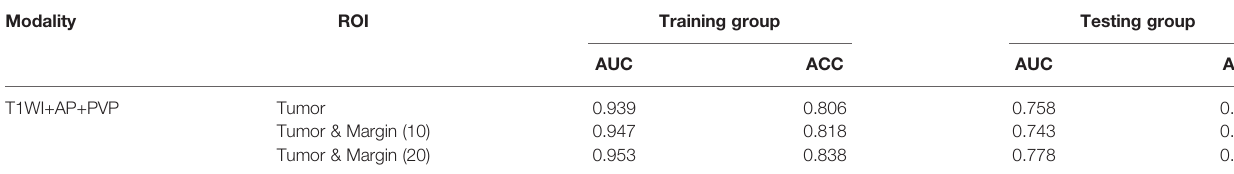
TABLE 4 | Multimodal radiomics models based on different ROIs.